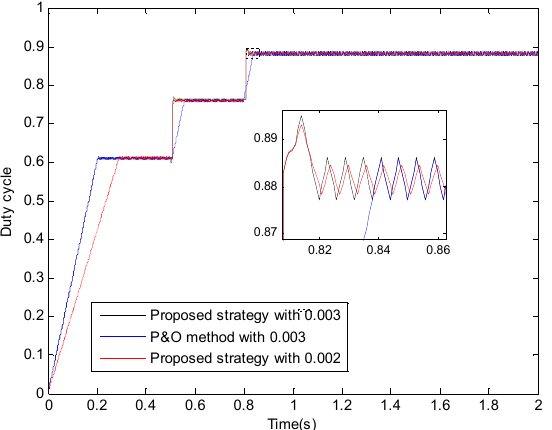
Figure 31. Duty cycle curves under different step size conditions.